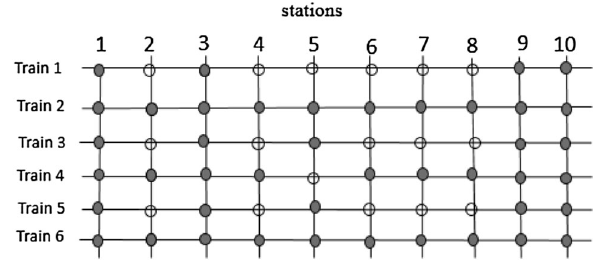
Fig. 2 The stop-skip pattern for trains running on Line